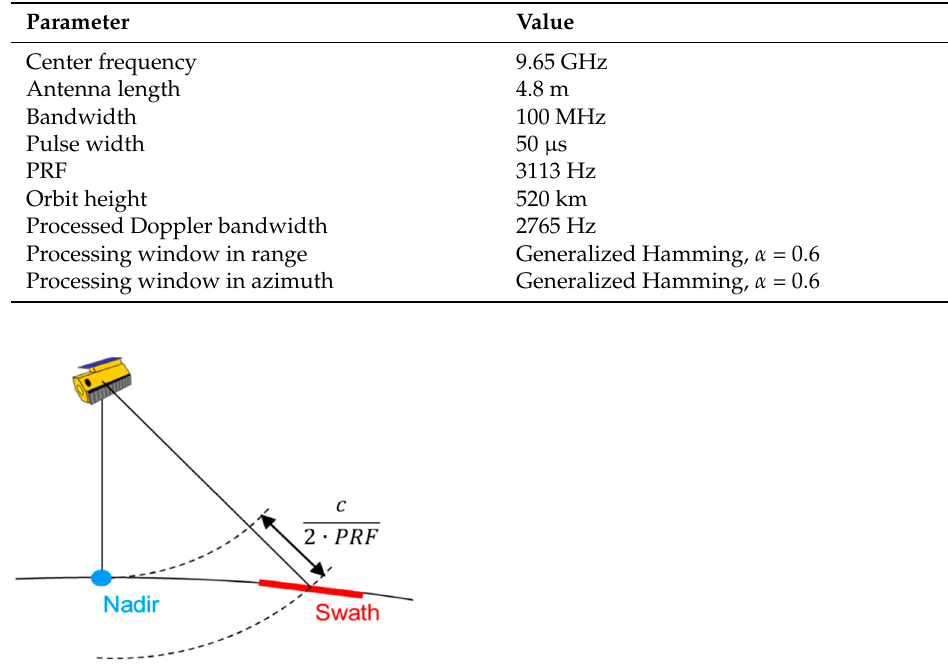
Table 1. System and Processing Parameters.